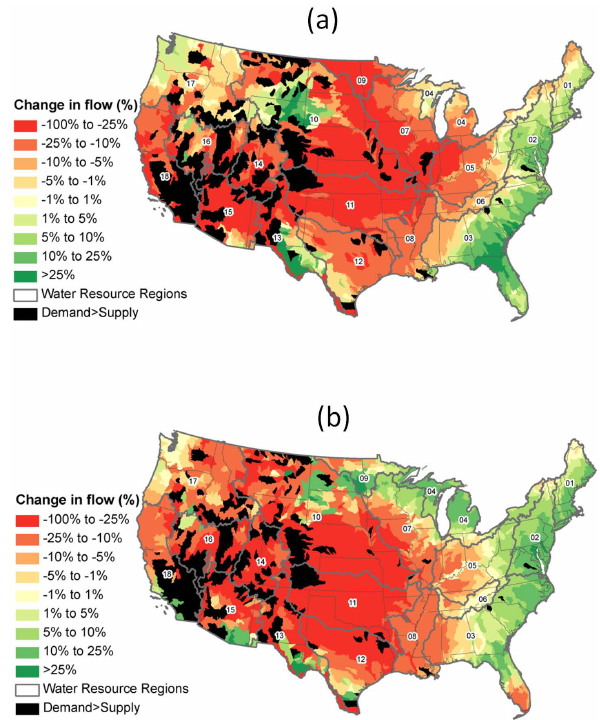
Fig. 7. Impact of impervious, population, and climate change on mean annual flow in 2060 for the Low (a) and High (b) growth and emission scenarios from the baseline case of 1981–2000 climate with 2005 water withdrawals and 2010 impervious cover. Gross de- mand in black areas is greater than the sum of surface water sup- ply and groundwater withdrawals, indicating likely transfer of water from other